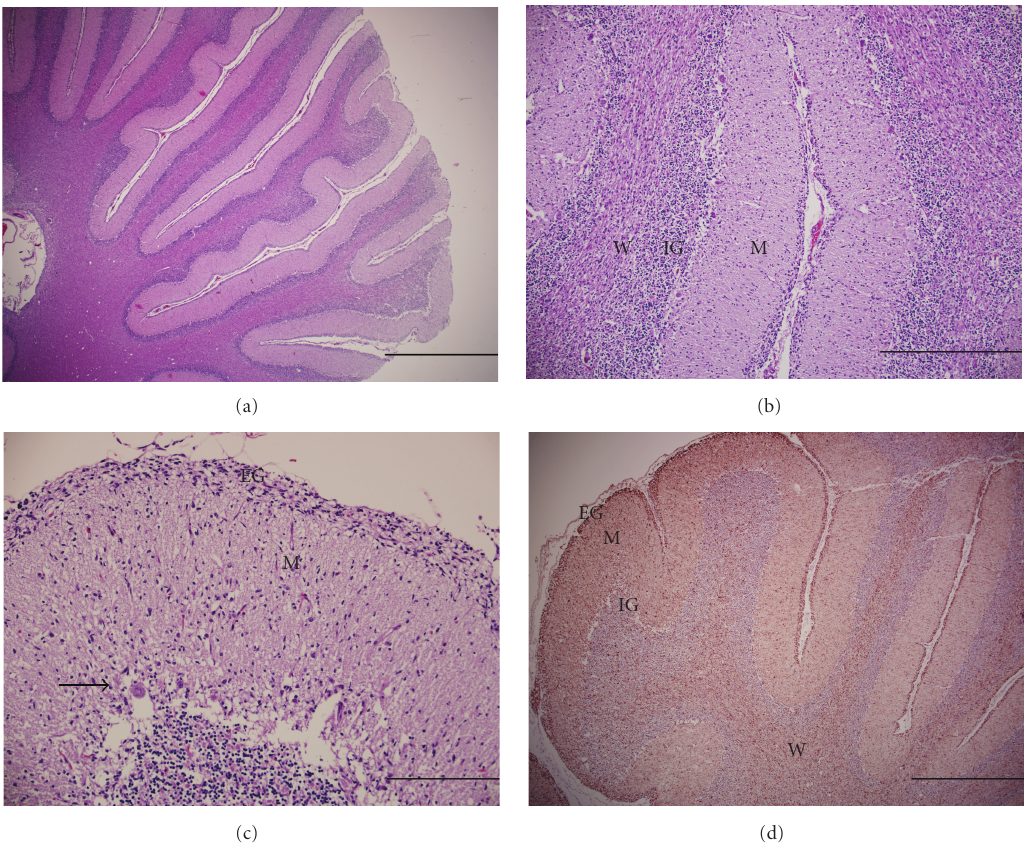
Figure 1: Cerebellum, dog. (a) Multifocal thinning of the cerebellar folia. Hematoxylin and eosin stain (HE). Bar: 1 mm. (b) Moderate hypocellularity of the inner granular layer (IG), increased cellularity in the white matter (W), and a well-defined molecular layer (M). HE stain. Bar: 500 µ m. (c) Moderate, multifocal depletion and degeneration of purkinje cells (arrow) and partial retention of the external granular layer (EG). HE stain. Bar: 200 µ m. (d) Marked astrogliosis evidenced by positive GFAP immunostaining in the external granular layer (EG), molecular layer (M), inner granular layer (IG), and white matter (W). Immunoperoxidase with 3-, 3 (cid:2) -diaminobenzidine with Mayer’s hematoxylin counterstain. Bar: 1